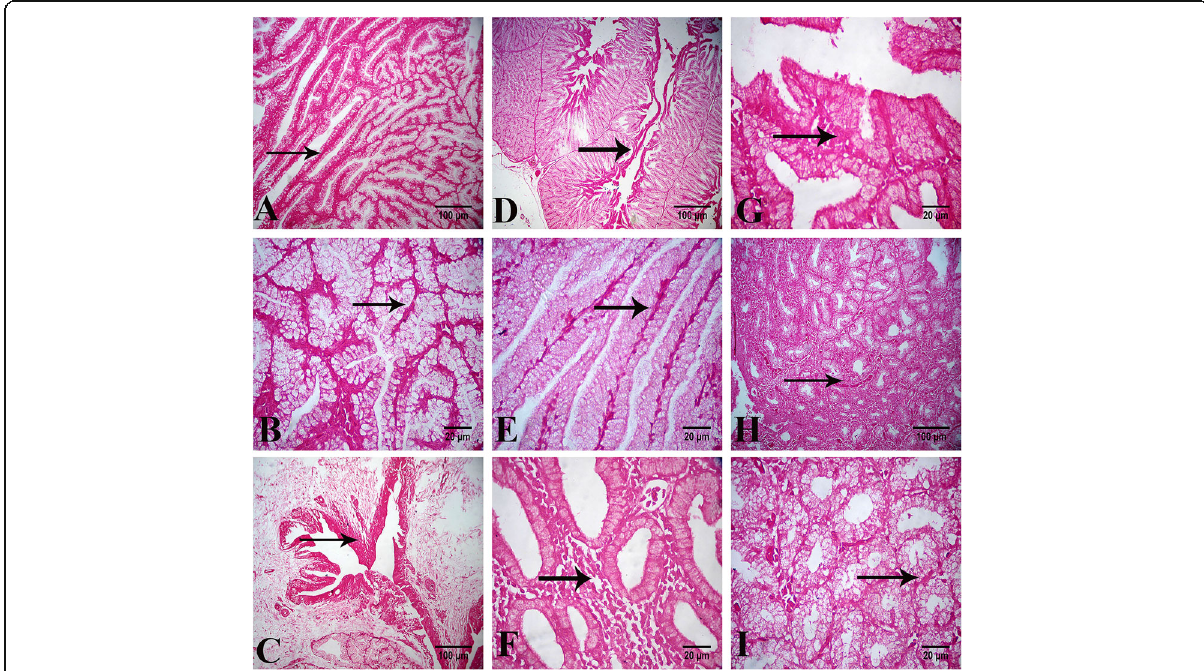
Fig. 12 Light micrograph of the HG of duck ( A , B , C ), goose ( D , E ), ibis ( F , G ), and pigeon ( H , I ). Positive reaction was observed in the centrally located cells of glandular epithelium of tubules and glandular epithelium of acini, in the connective tissue septa between the secretory end pieces and in the excretory duct with periodic acid Schiff reagent. Stain, PAS